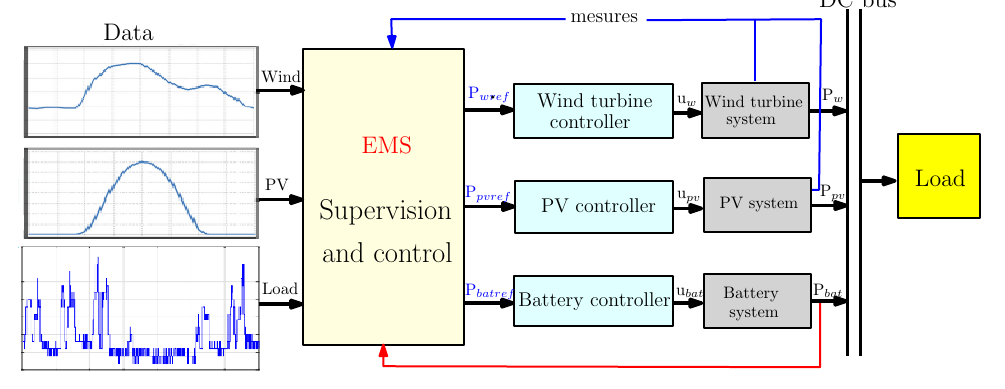
Figure 8. Global EMS control